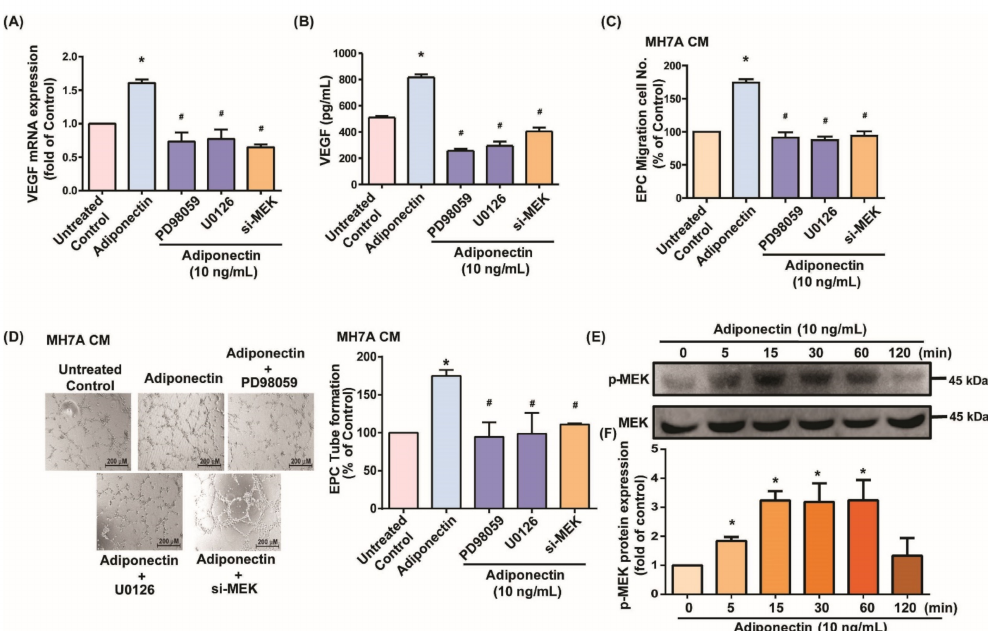
Figure 3. The MEK signaling pathway is required in adiponectin-induced EPC migration and tube formation. ( A , B ) MH7A cells were left untreated, stimulated with adiponectin (10 ng/mL) alone for 24 h, or pretreated with MEK inhibitors (PD98059 and U0126) or transfected with MEK siRNA for 30 min, prior to 24 h of adiponectin (10 ng/mL) stimulation. VEGF expression was examined by qPCR and ELISA assays ( n = 4 per group). ( C , D ) Collected CM from MH7A was applied to EPCs and angiogenesis was examined by the Transwell and tube formation assays ( n = 5 per group). ( E ) MH7A cells were treated with adiponectin for varying amounts of time and Western blot ( n = 3) determined MEK phosphorylation. ( F ) Densitometry analysis of ( E ). * p < 0.05 versus the control group; # p < 0.05 versus the adiponectin-treated group.